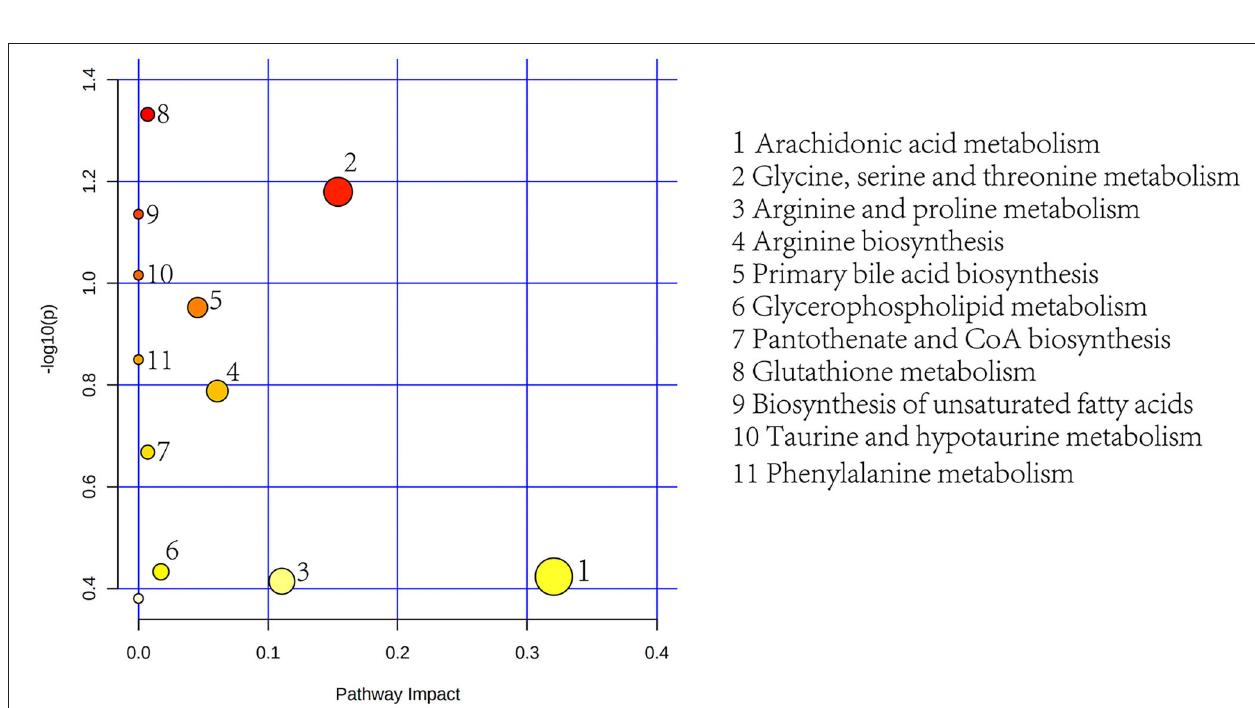
FIGURE 7 | The different metabolites in feces between NCG group ( N = 8) and CON group ( N = 6) are classified according to the HMDB Compound Classification. The inner pie chart is the classification of the differential metabolites in the Super Class, and the outer pie chart is the classification of the differential metabolites in the Class, and the Class belongs to the Super Class. The contents of gray box corresponding to the outer pie guided by the indicator line represents the name of the Class, the number and proportion of differential metabolites in the feces.